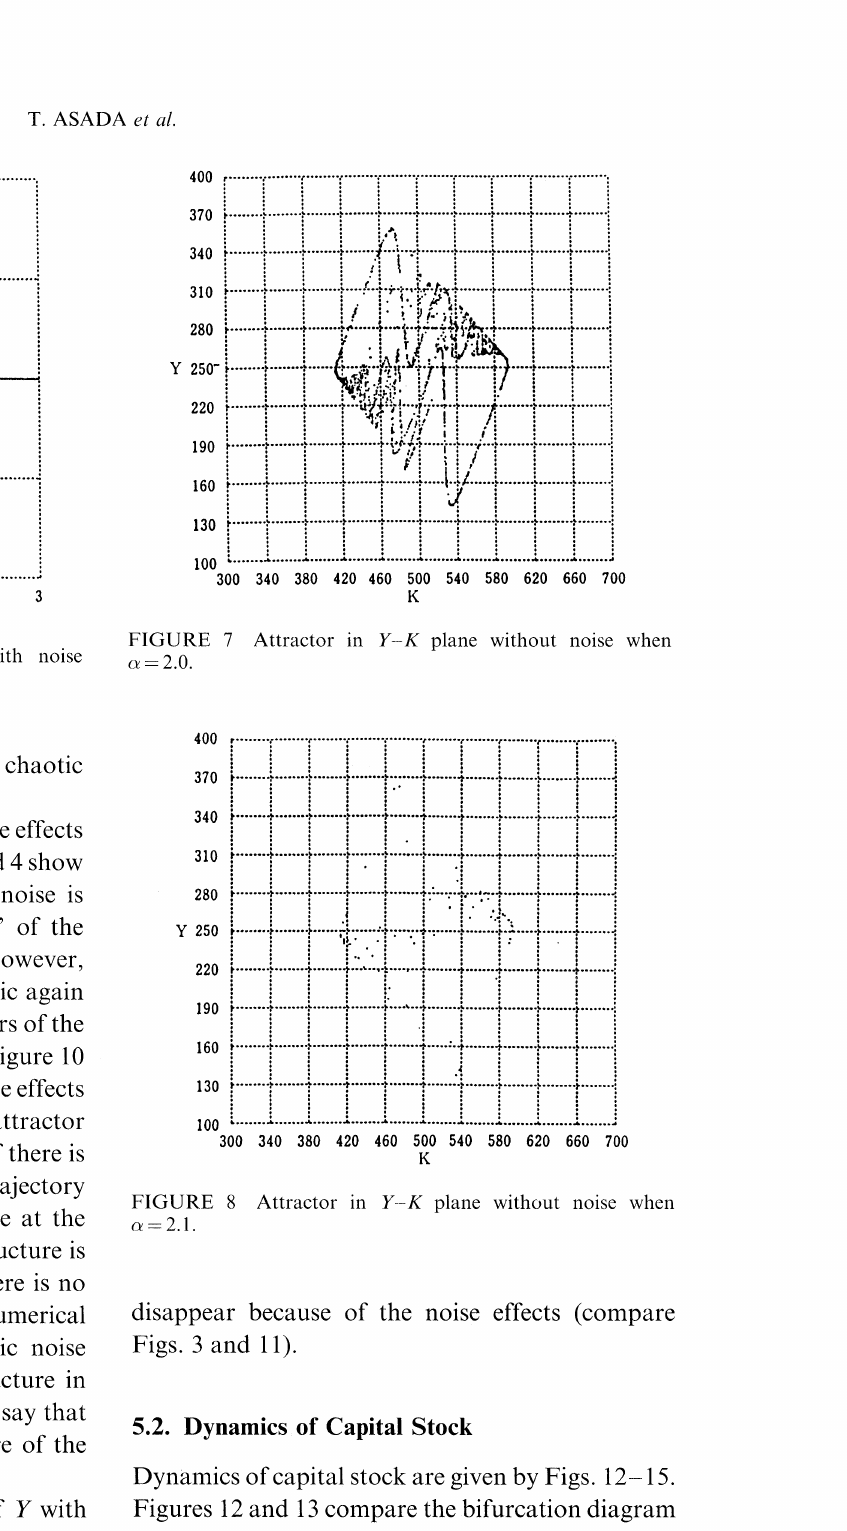
FIGURE 8 Attractor in Y-K plane without noise when